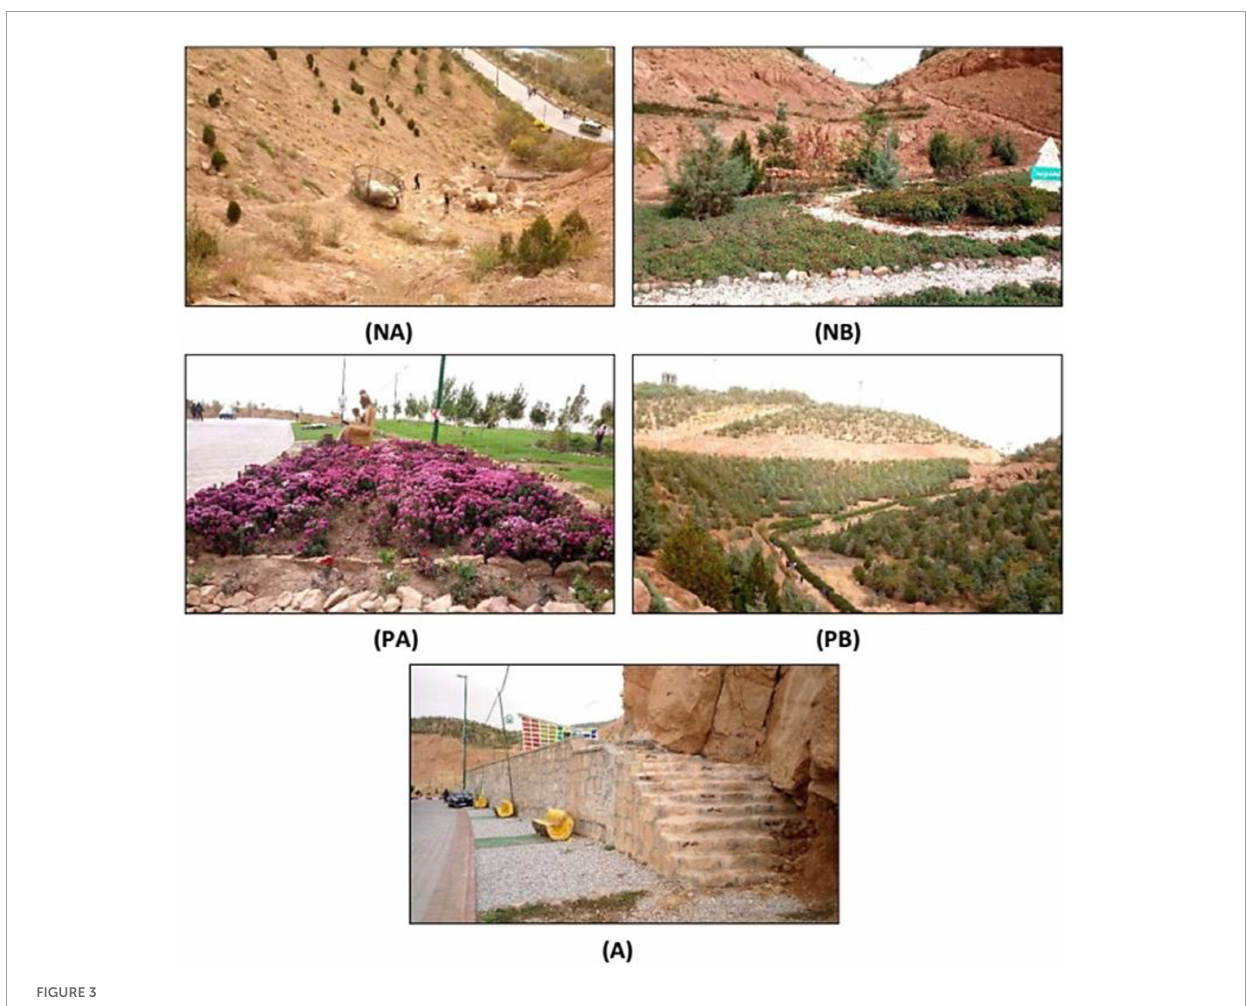
FIGURE3 The nature categories of Eynali woodland park (own design by authors).